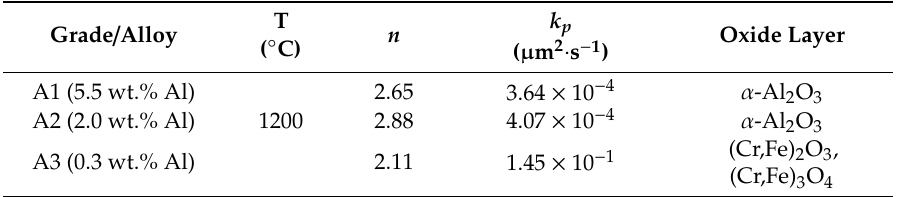
Table 3. The results of analyses of the oxide scales.